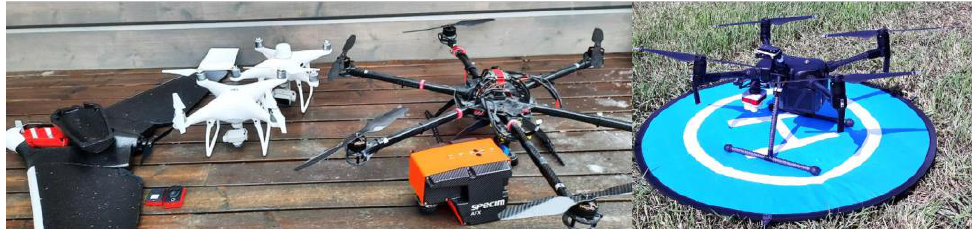
Figure 2. Four types of unmanned aerial vehicles (UAVs), shown from left to right: (1) fixed-wing Parrot Disco and Parrot Sequoia multispectral camera; (2) DJI Phantom 4 and Phantom 4 Multispectral RTK; (3) custom-built Carboncore hexacopter and Specim AFX10 push-broom hyperspectral camera; and (4) DJI Matrice 210 with Micasense Altum multispectral camera onboard.